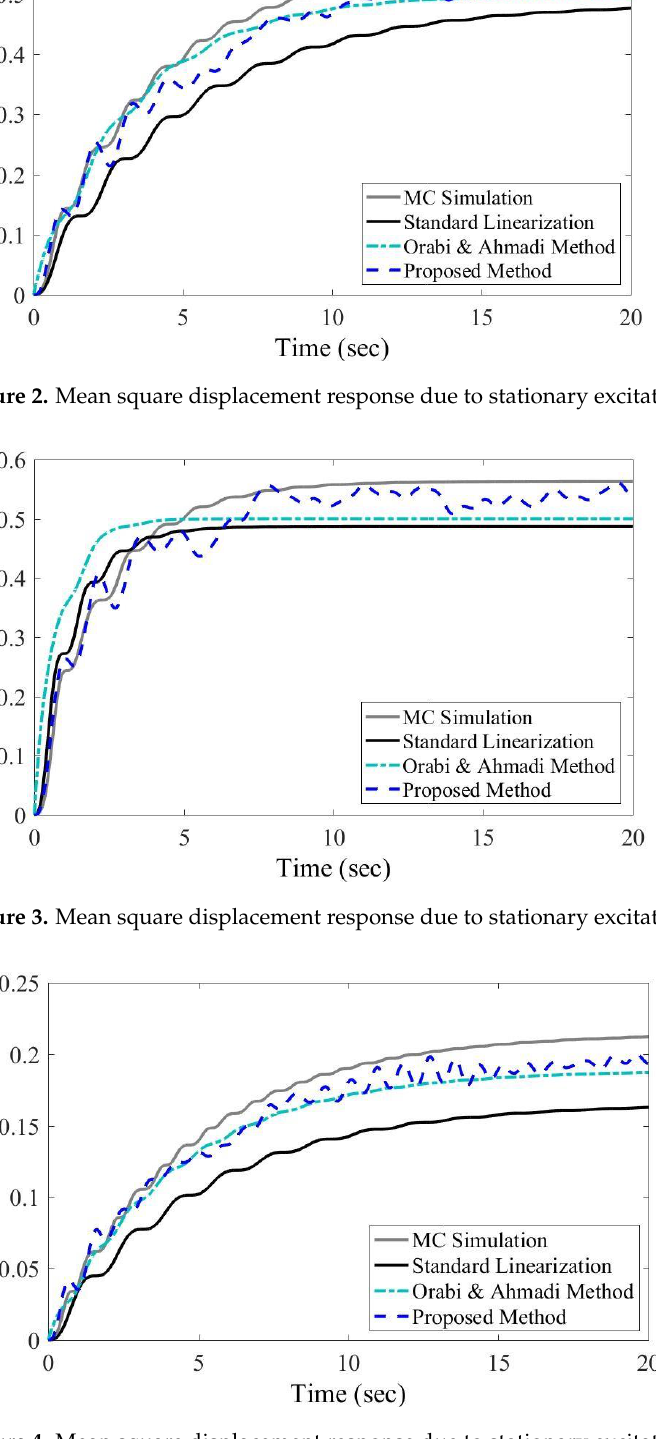
Figure 5. Mean square displacement response due to stationary excitation. ( γ = 10.0, μ = 10.0). It is observed from Figures 2 – 5 that besides the standard equivalent linearization method and the iteration method proposed in [10], the proposed orthogonal-function- based equivalent linearization method also underestimates the transient mean square re- sponse of the studied SDOF Duffing – Van der Pol oscillator. However, when compared